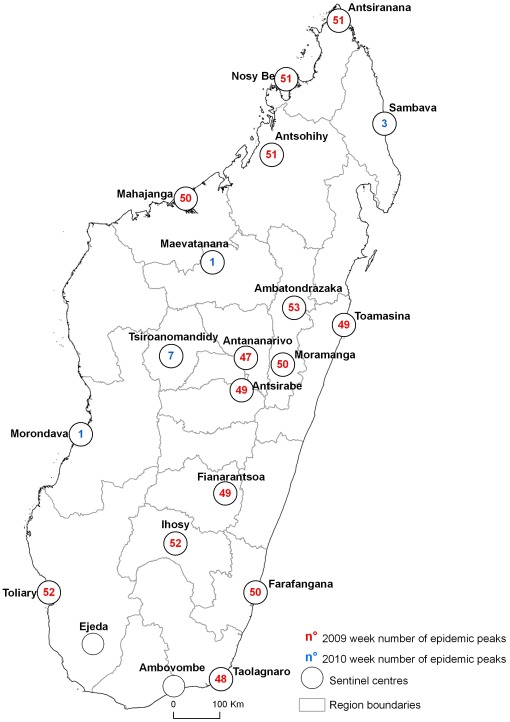
A(H1N1)pdm09 diffusion in Madagascar-the “peaks road.”